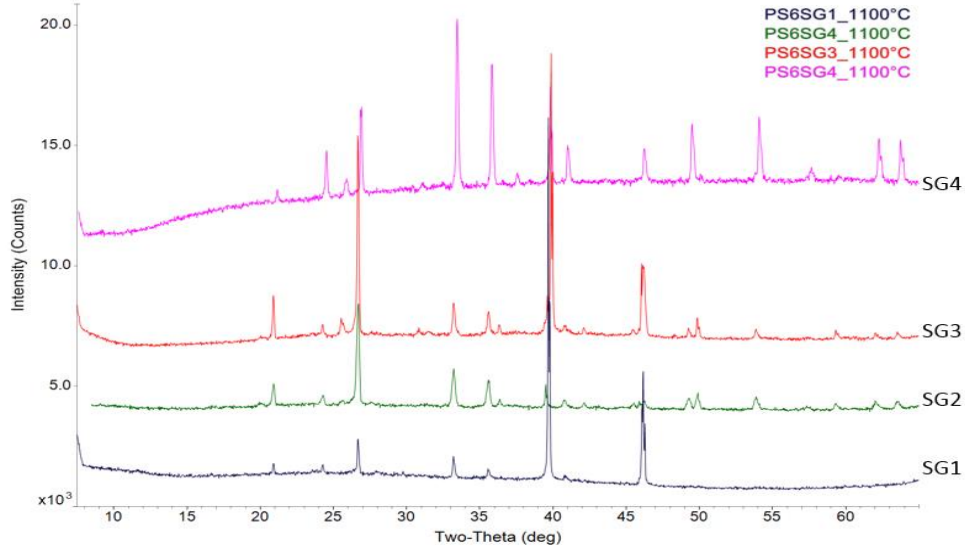
Figure 7. Presence of CaO only in SG4 density fraction at 1100 °C.